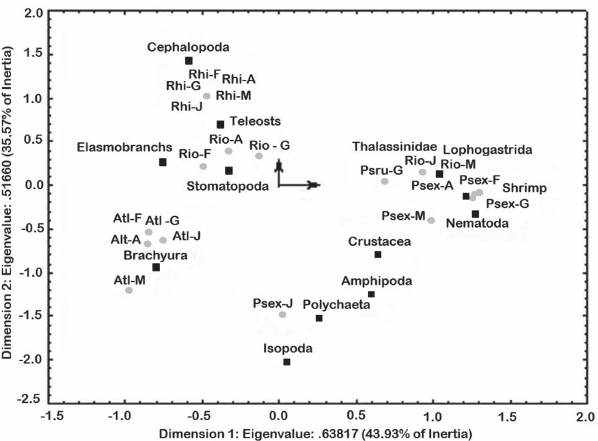
Fig. 4. Correspondence analysis. Projection on factorial planes 1-2 by food items, of species (Atl = Atlantoraja cyclophora , Rio = Rioraja agassizii , Psex = Psammobatis extenta , Psru = Psammobatis rutrum and Rhi = Rhizoprionodon lalandii ) according to sex and stages of maturity (G= general, M = males, F = females, J = juveniles and A = adults), in the southeastern